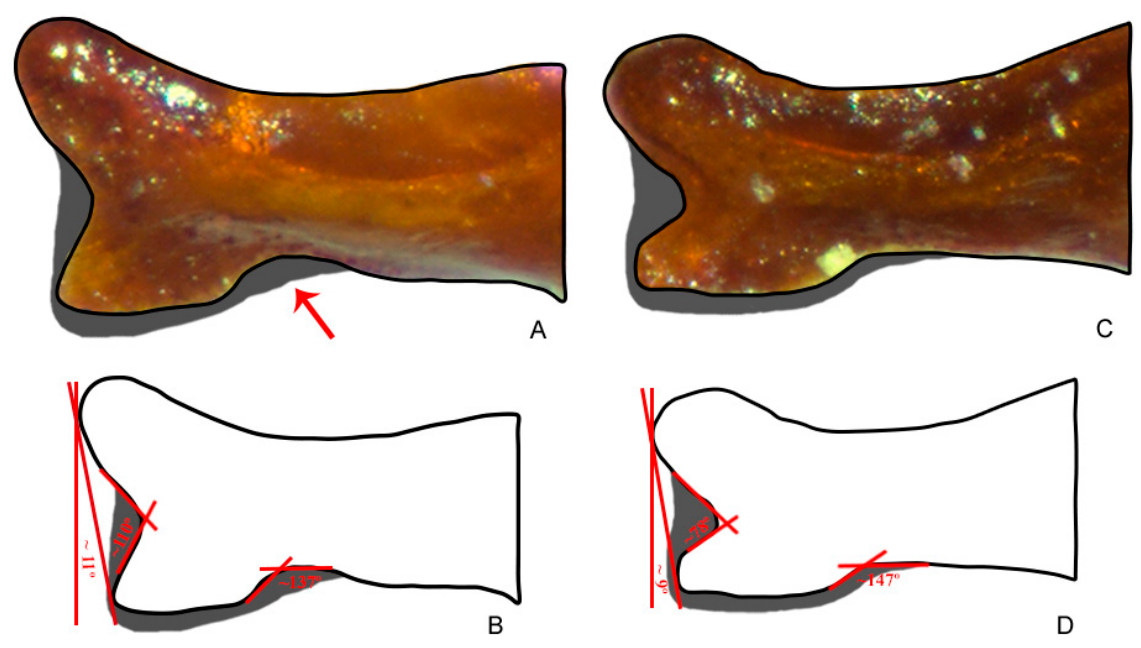
Fig. 44. Differences on the parameres of Sylvicanthon mayri sp. nov. and S. monnei sp. nov. (grayish zones represent original membraneous areas). A–B . S. mayri sp. nov. C–D . S. monnei sp. nov. Note that both branches of the apical bifurcation of the parameres of S. mayri sp. nov. are much more divergent than those of S. monnei sp. nov., which makes the internal angle between them more open in the first species (~110º) than in the second (~78º). In the same way, as the inferior branch is much more projected in S. mayri sp. nov. than in S. monnei sp. nov., the angle between the posterior region of that branch and the rest of the paramere is more open in S. monnei sp. nov. (~147º) than in S. mayri sp. nov. (~137º), species that seems to have a strong excavation at this point of the paramere (indicated by red arrow in